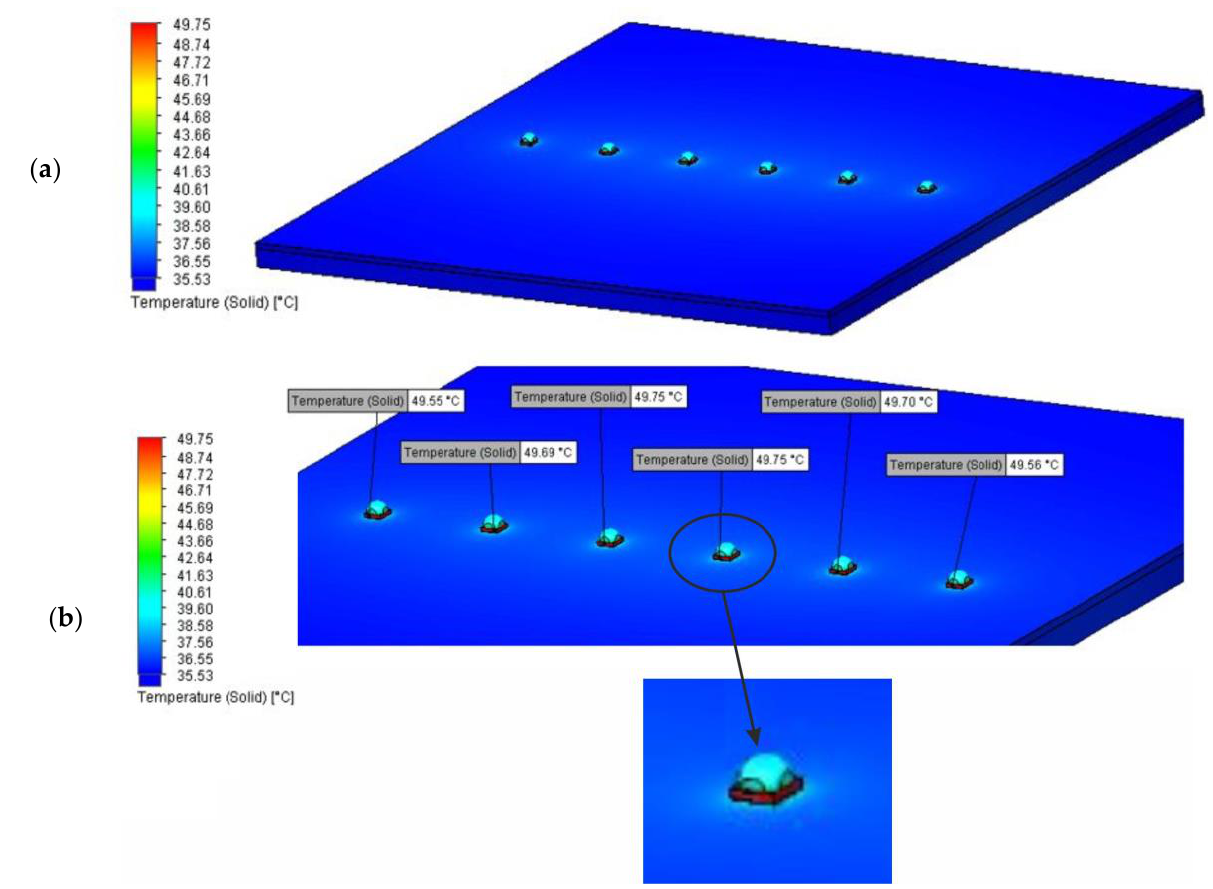
Figure 8. 6 × 1 LED panel, I F = 700 mA: ( a ) temperature distribution for the tested panel, ( b ) deter- mined junction temperature T j of individual LEDs.